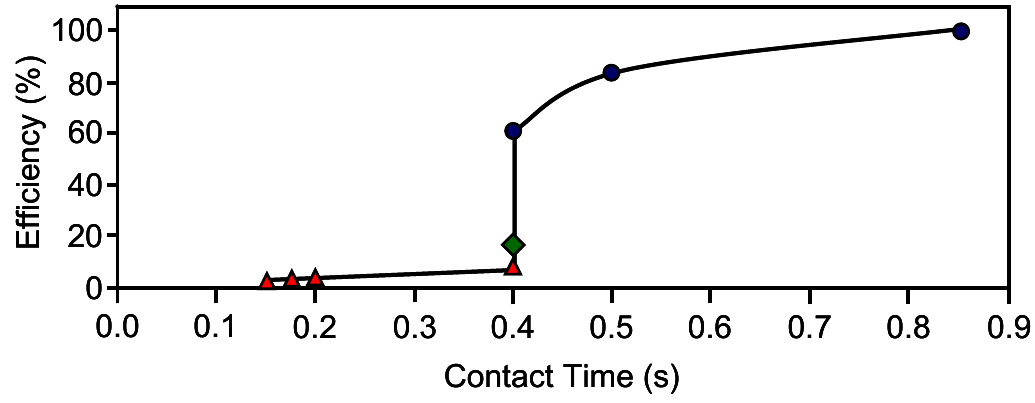
Figure 9. The dynamic adsorption efficiency towards o-DCB for different contact times and temperatures: 30 ºC ( ), 100 ºC ( ) and 150 ºC ( ). From reference [43], with permission from